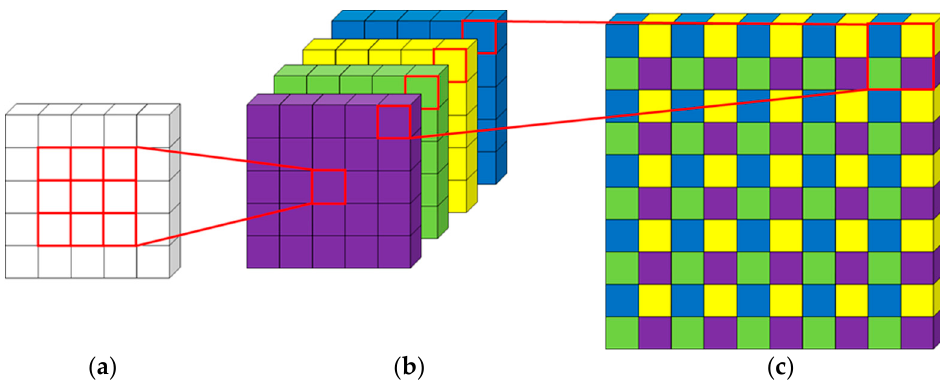
Figure 6. Spatial Attention Module: ( a ) Input Feature Map; ( b ) the feature map resulting from the convolution; ( c ) feature map rearranged from the convolution feature map.